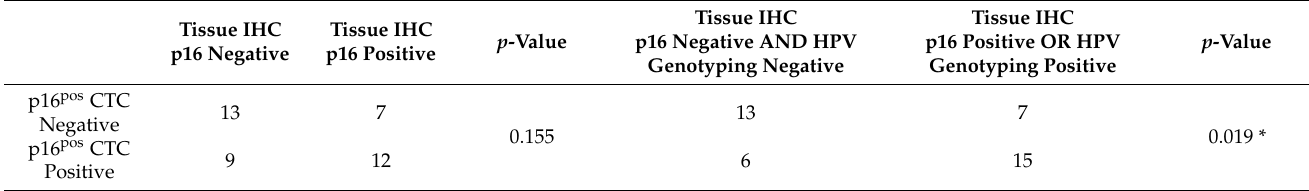
Table 2. Comparison between tissue p16 and blood p16